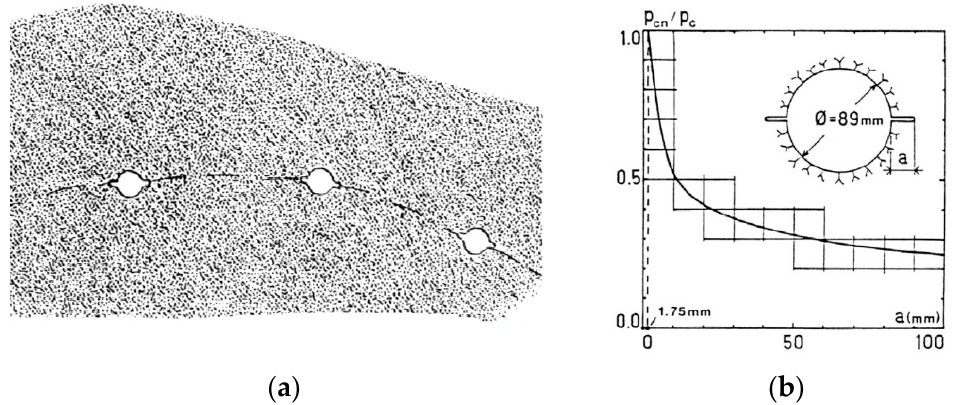
Figure 12. ( a ) Reduced spacing as a result of holes (notched by water jet) able to guide the fracture in the wanted direction; ( b ) gas pressure necessary for the propagation of the fracture in a blast hole with a diameter of 89 mm, performed in granite, depending on the length of the notch. p c = critical pressure without notch; p cn = critical pressure with notch [17].